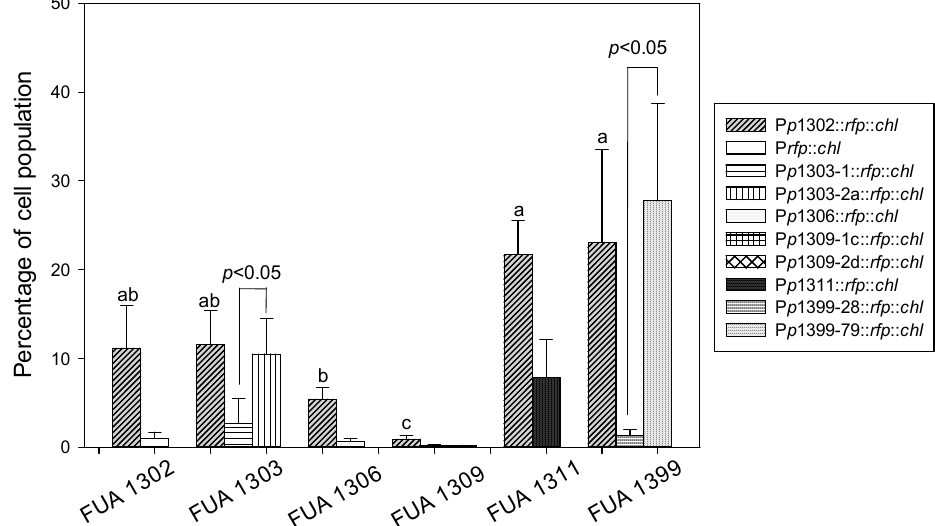
Figure 7. Percentage of the population of strains of E. coli expressing DsRed under the control of different Shiga-toxin regulatory sequences. To determine the effect of the native regulator to the p R’ region, the p R’:: rfp :: chl r constructs were cloned from the target strains and transformed back into their parent strains. To determine whether the same p R’ region was differentially expressed in different strains, the construct p 1302:: rfp :: chl r was transformed into all target strains and its parent strain E. coli FUA1302 O104:H4. Transformants were induced with MMC. Bars are grouped by the six target strains, the bars represent different p R’ constructs shown in the figure legend. Bars with the same pattern that do not share a common letter differed significantly. The percentage of fluorescent cells are shown as mean ± standard deviations of quadruplicate independent experiments ( p ≤ 0.05).